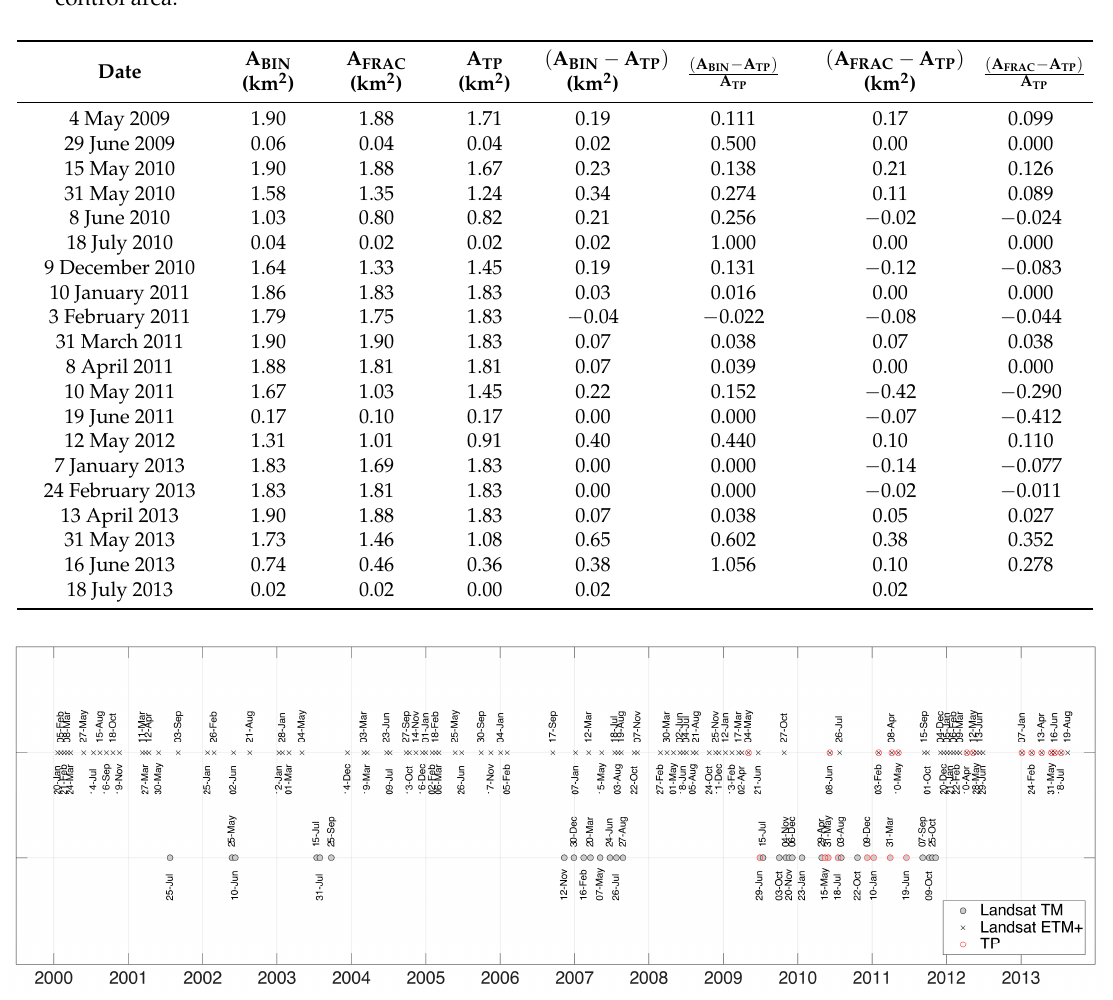
Figure 2. Landsat scenes, TM (grey dots) and ETM+ (black crosses) analyzed throughout the study period 2000–2013 over Sierra Nevada Mountain. Available Terrestrial Photography (TP) used as validation dataset (red dots) over the control area throughout the validation period (2009–2013).